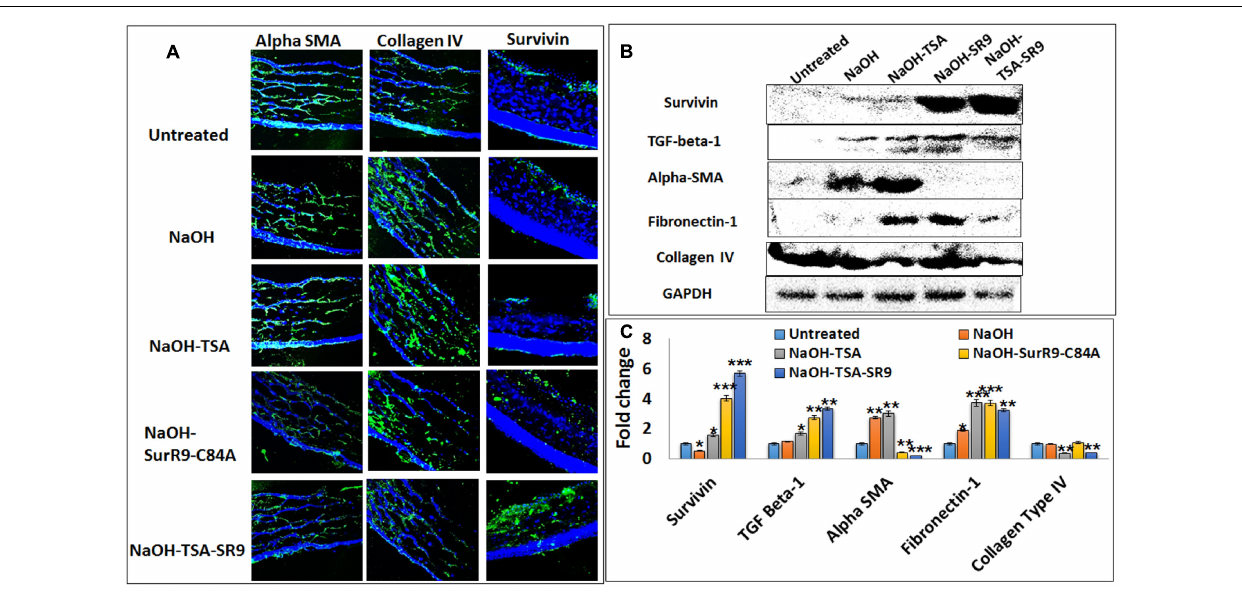
FIGURE 3 | Analysis of protein expression for key tissue integrity markers: (A) Immunofluorescence staining was performed for expression of alpha-SMA, collagen type IV and survivin in rat corneal tissues. (B) Western blotting analysis was performed to confirm the protein expressions of survivin, TGF-beta-1, alpha-SMA, Fibronectin-1 and collagen type IV in rat corneal lysates. Each blot was repeated thrice and a representative blot has been presented. (C) Band density analysis was carried out for the western blots using the image J software. (SR9=SurR9-C84A). Five images of each treatment were taken for immunofluorescence studies and a representative image has been presented. ∗ p < 0.05, ∗∗ p < 0.01, and ∗∗∗ p <